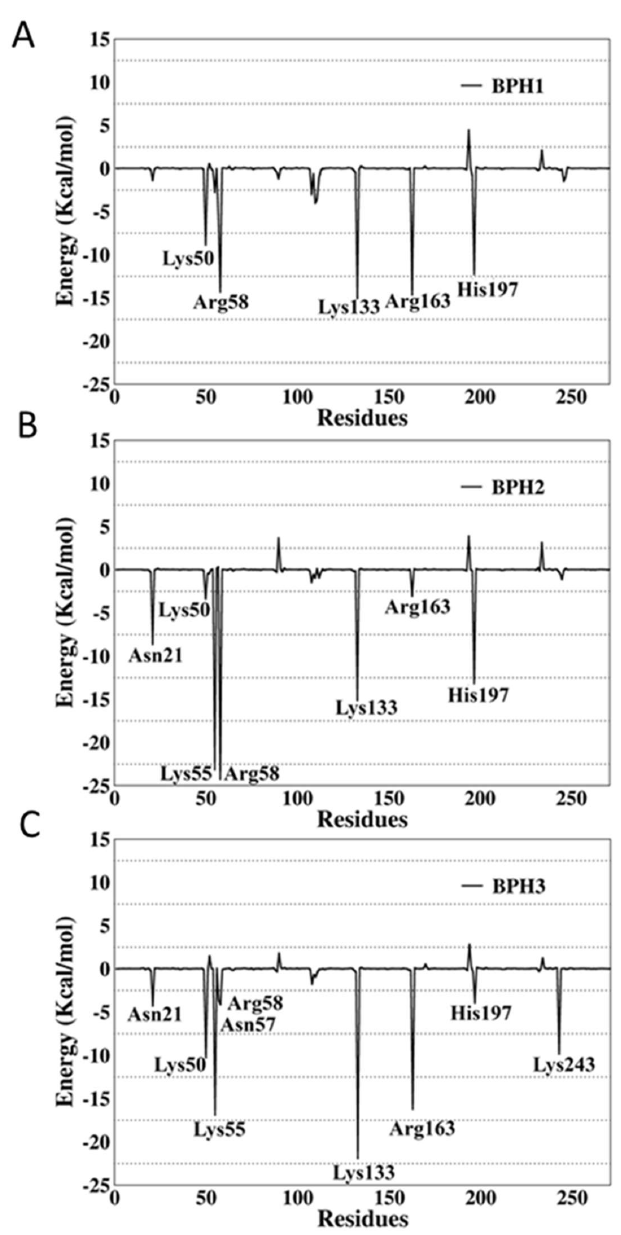
Figure 7. Per-residue decomposition analysis of ( A ) BPH1, ( B ) BPH2, and ( C ) BPH3 in complexes with the KDO8P synthase from N. meningitidis .